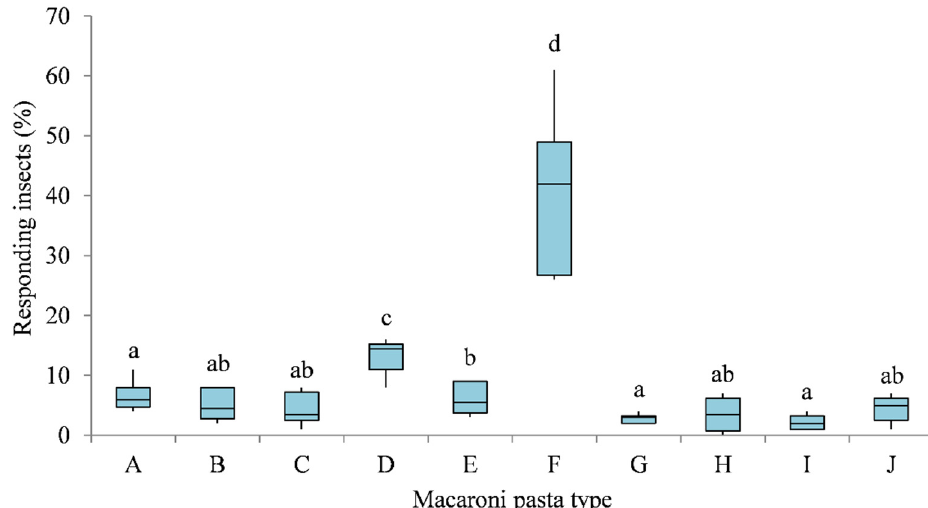
Figure 2. Olfactory responses of S. granarius adults to Durum wheat pasta ( A ), Durum whole wheat pasta ( B ), Spelt pasta ( C ), Five cereals pasta ( D ), Kamut pasta ( E ), Khorasan pasta ( F ), Lens pasta ( G ), Chickpea pasta ( H ), Pea pasta ( I ), and Faba bean pasta ( J ) macaroni pasta in 7-days multiple-choice bioassays. Each box plot indicates the median and its range of dispersion (lower and upper quartiles and outliers). Above each box plot, different letters indicate significant differences (Wilcoxon test, p < 0.05).